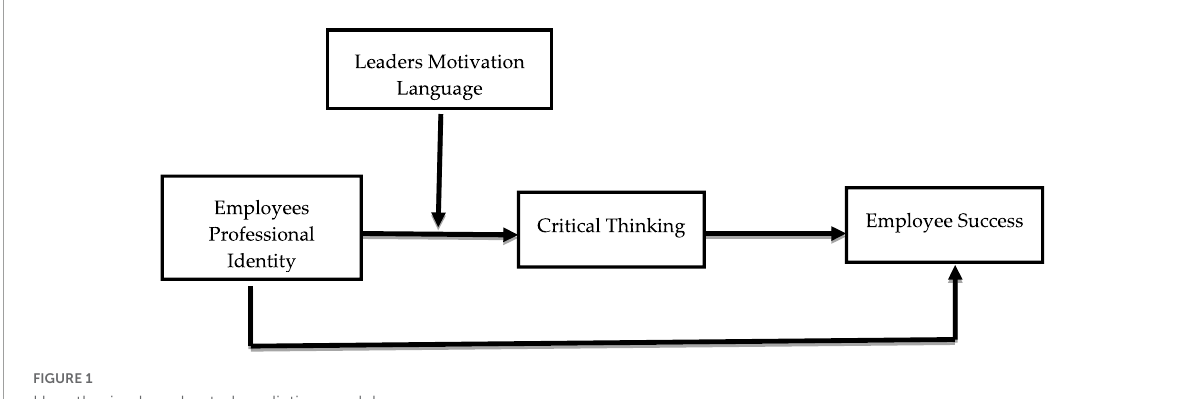
FIGURE1 Hypothesized moderated mediation